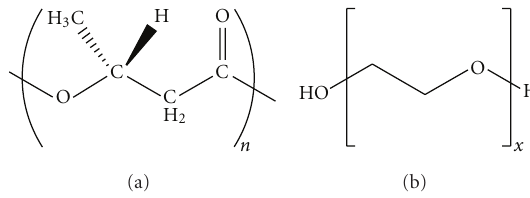
Figure 1: Chemical formulae for biomacromolecules (a) poly(3-